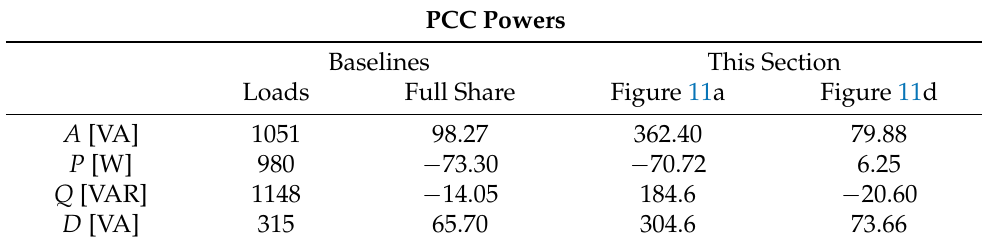
Table 5. Steady-state power terms at the PCC for Figure